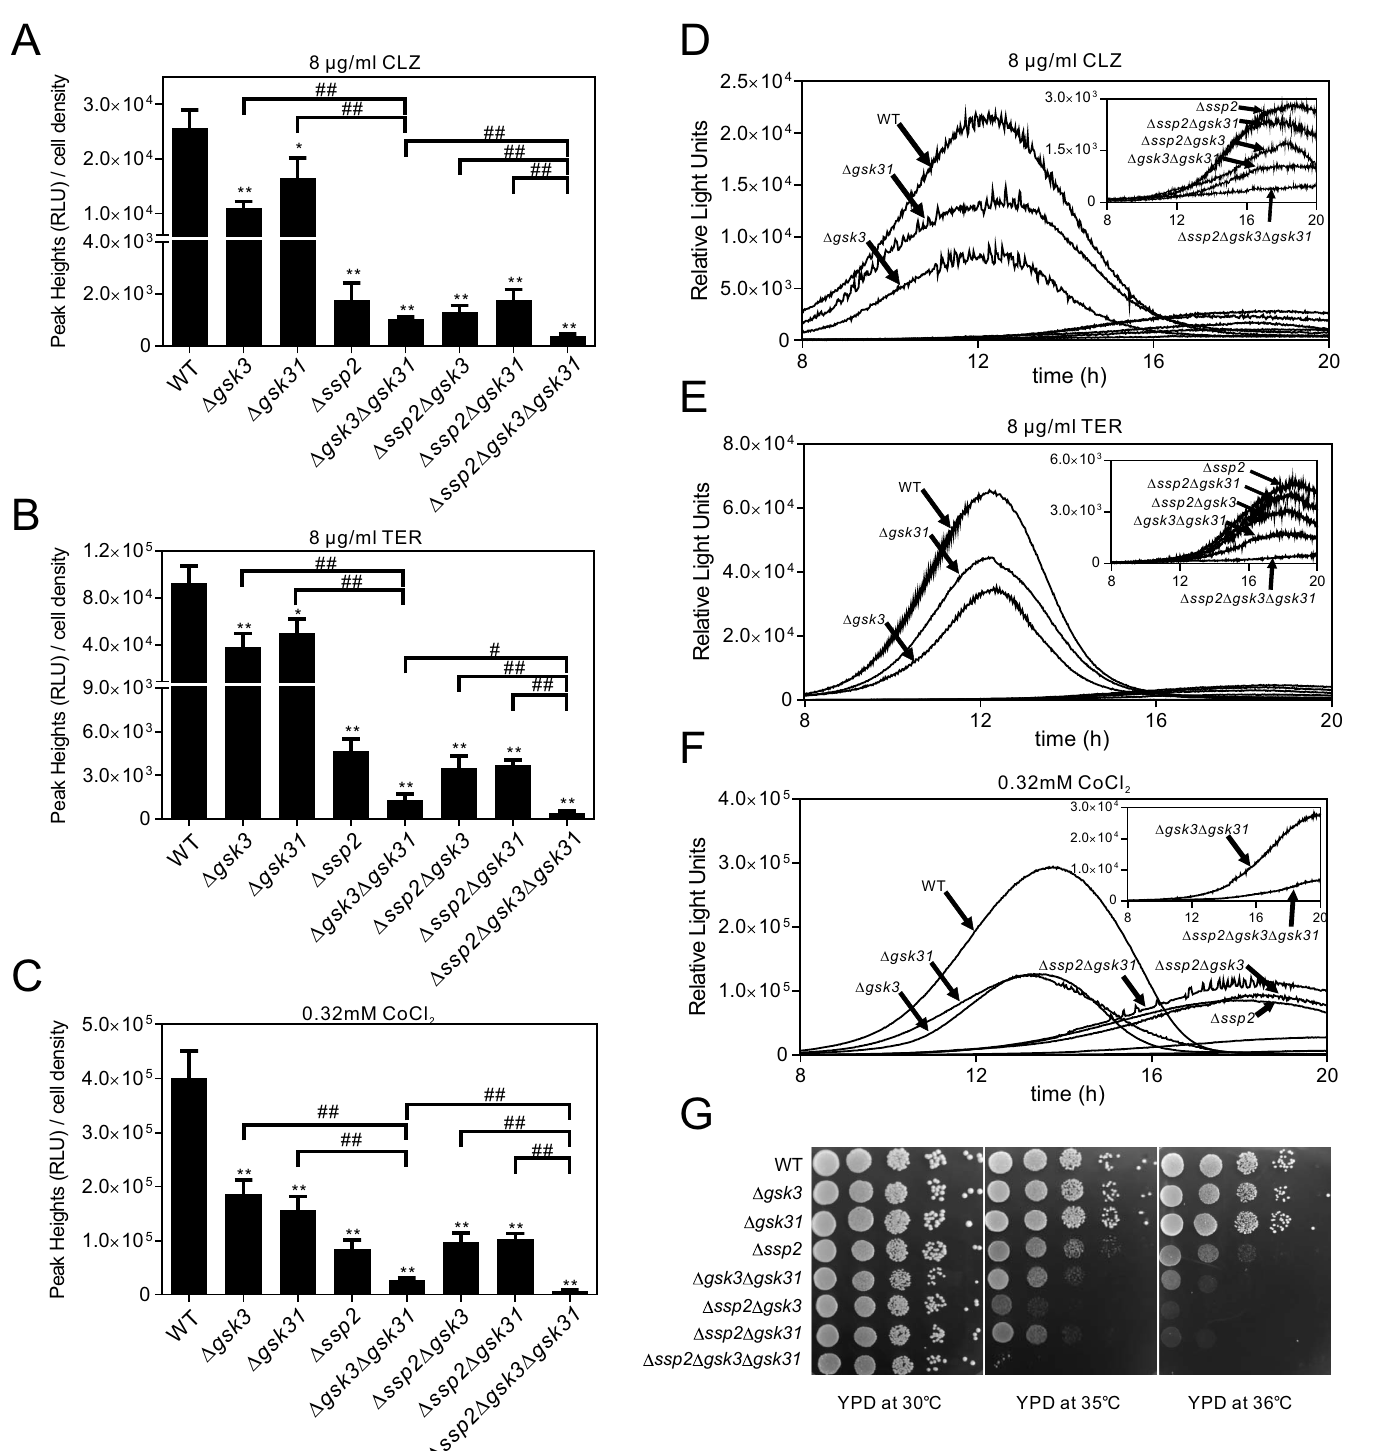
Fig 5. Deletion of Ssp2 or/and Gsk3/Gsk31 markedly suppressed CLZ, TER or CoCl 2 -induced Sre1 activity. The Δ ssp2 , Δ gsk3 Δ gsk31 , Δ ssp2 Δ gsk3 , Δ ssp2 Δ gsk31 or Δ ssp2 Δ gsk3 Δ gsk31 cells showed a significant decrease in Sre1 activity and delay in the peak rising of the SRE2 reporter stimulated with 8 μ g/ml CLZ (A) , 8 μ g/ml TER (B) or 0.32 mM CoCl 2 (C). Cells harboring the multicopy reporter plasmid were cultured and assayed as described in Fig 1A–1C. Y-axis values are the relative light units (RLU) of peak height normalized to the cell density (OD660) of each sample at the peak time. The data were averaged from three independent experiments, and each sample was done in triplicate. Error bars indicate means (n = 3) ± S.D. � P < 0.05 and �� P < 0.01 compared with wild-type cells. #P < 0.05 and ##P < 0.01 compared